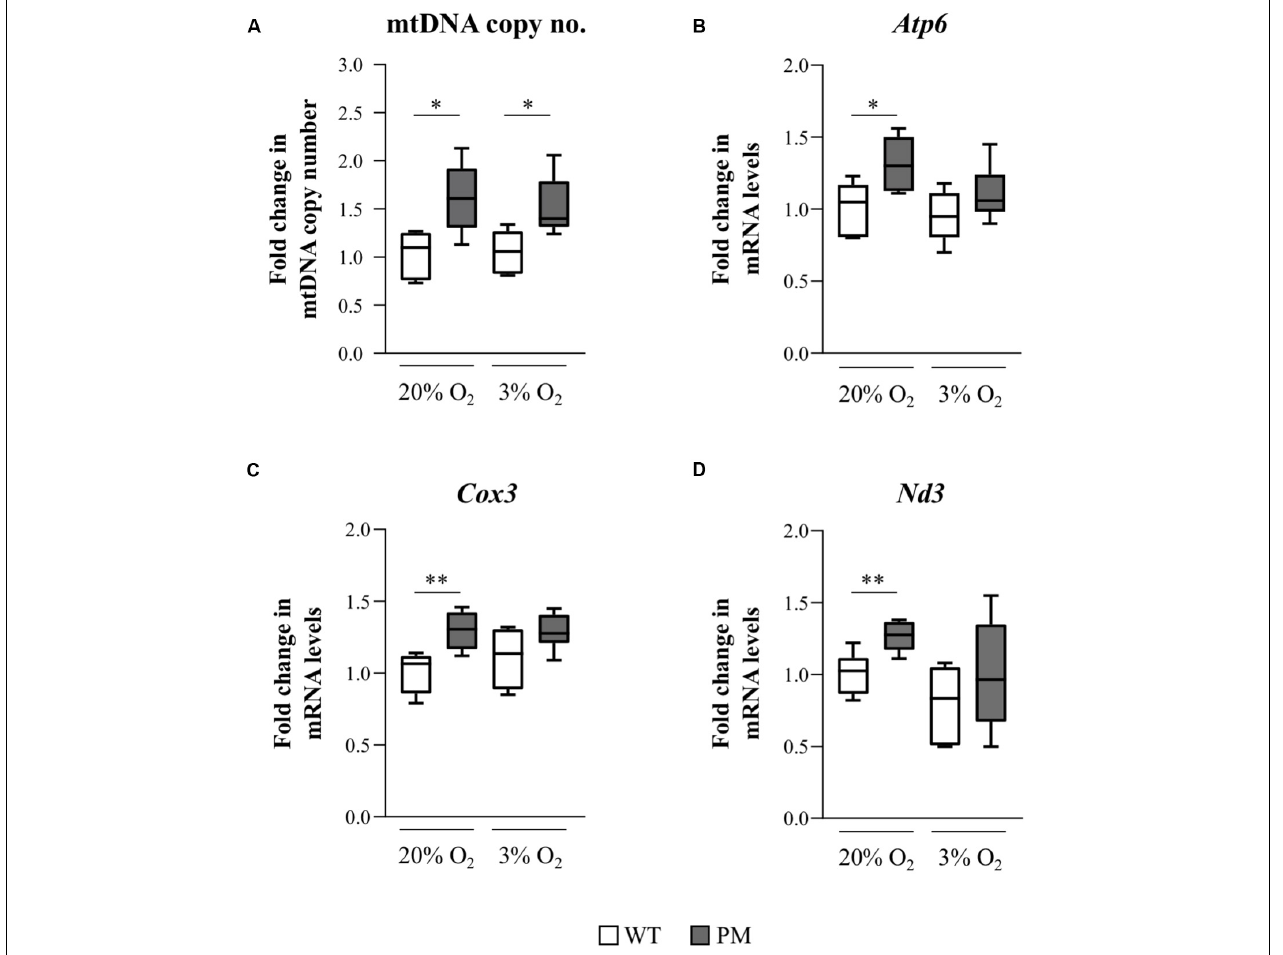
FIGURE 7 | Mitochondrial DNA copy number and mitochondrial gene expression in FX PM mESCs. (A) mtDNA copy number was measured using qPCR to determine levels of a mitochondrial gene, COXI, relative to a nuclear gene, GAPDH , in 3 WT and 3 PM lines cultured at 20% or 3% O 2 . Values are relative to the average value of WT cells cultured at 20% O 2 and displayed as mean ± SEM. n = 5; * p < 0.03. (B–D) Quantitative reverse-transcription-PCR analysis for the expression of the mitochondrial-encoded genes Atp6 (B) , Cox3 (C) , and Nd3 (D) in 3 WT and 3 PM lines cultured at 20% or 3% O 2 using β -actin for normalization. Values are relative to the average expression of the WT lines cultured at 20% O 2 and shown as mean ± SEM. n = 6; * p < 0.02; and ** p ≤